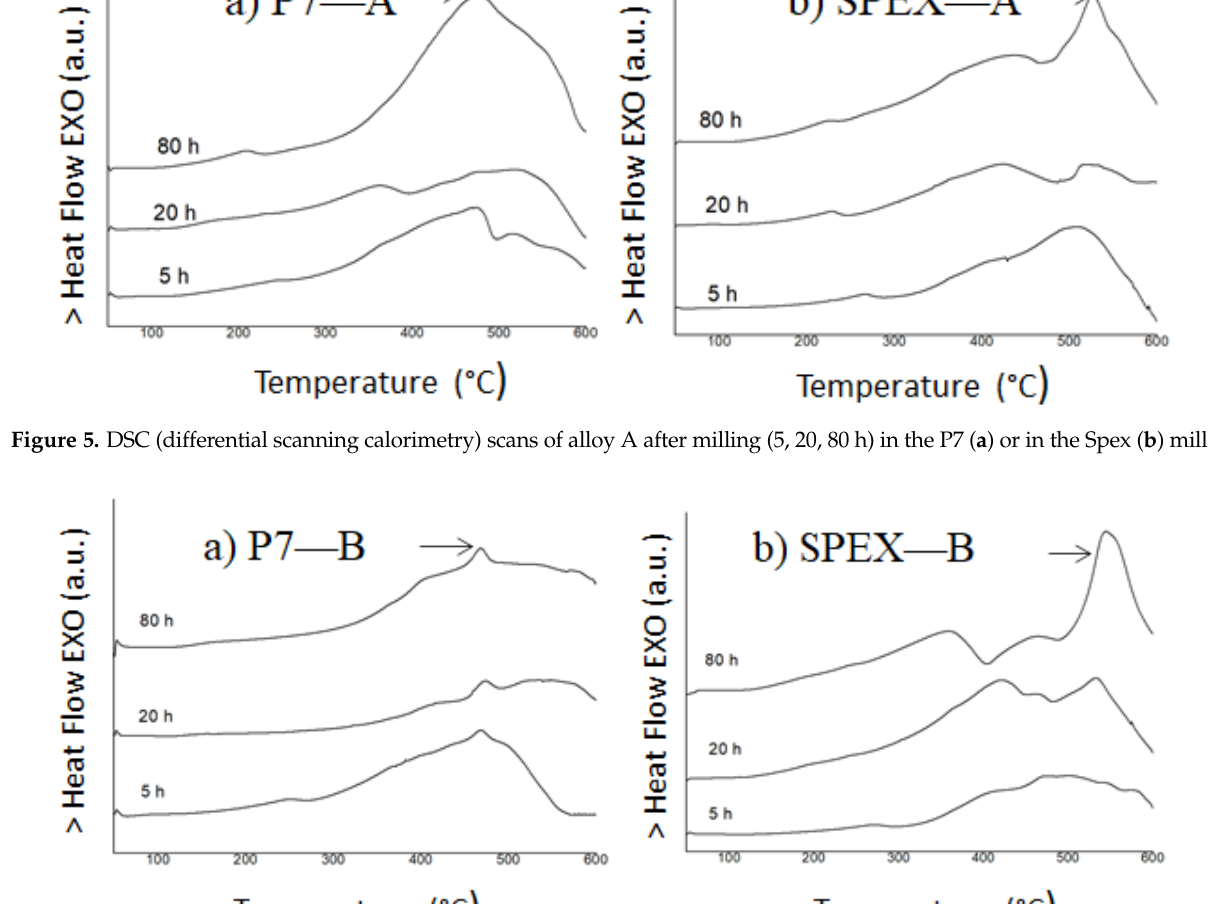
Figure 6. DSC scans of alloy B after milling (5, 20, 80 h) in the P7 ( a ) or in the Spex ( b )